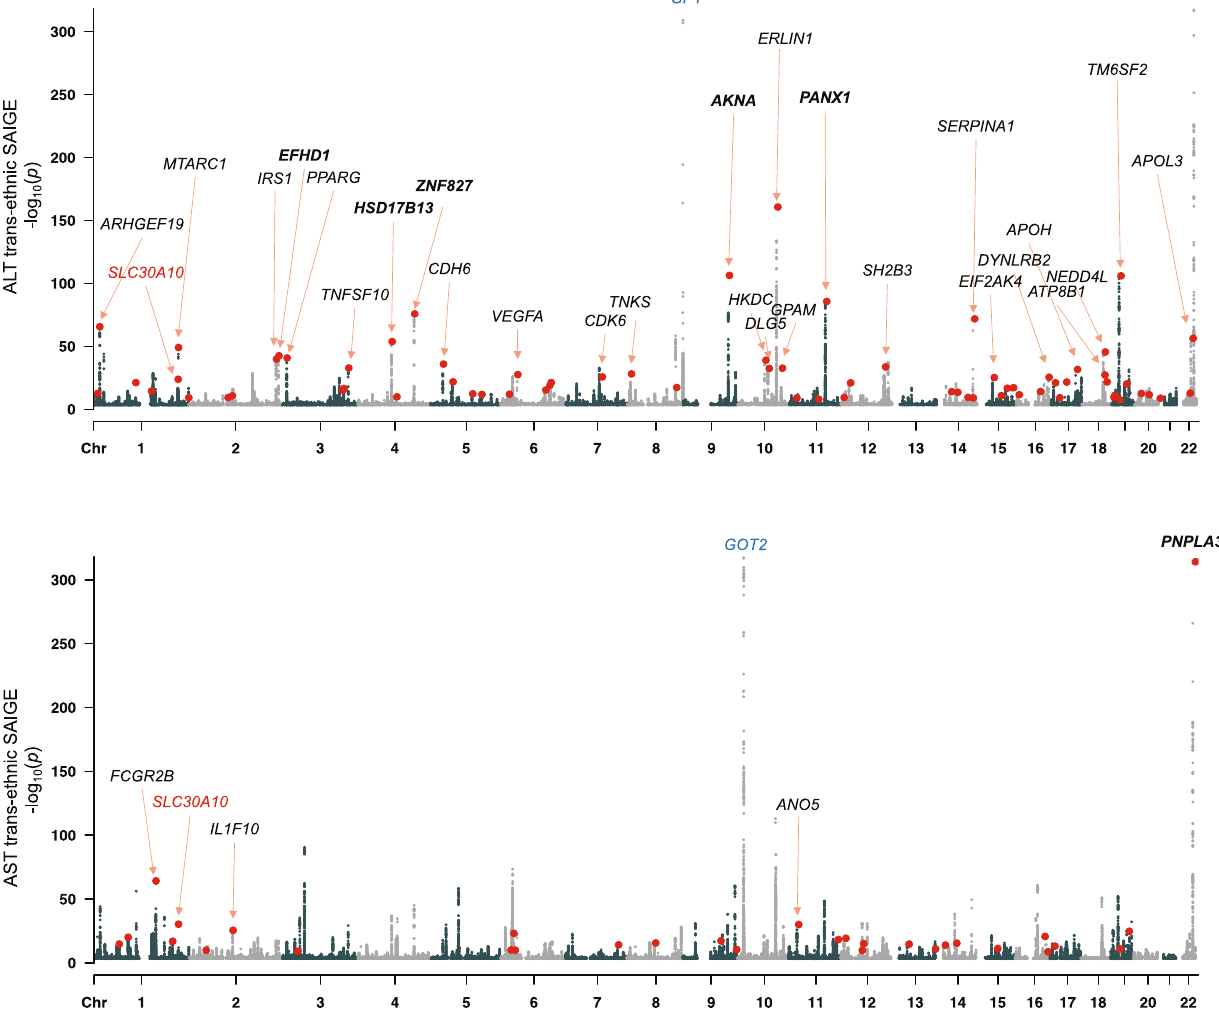
Fig. 1 Manhattan plots showing trans-ancestry GWAS results for ALT and AST. Red dots indicate lead variants for shared signals between the two GWAS; for clarity, the shared signals are marked only once, on the plot for the GWAS in which the more signi fi cant association is detected. Cis-pQTLs (at GPT and GOT2 ) are labeled in blue. Loci with shared signals are labeled (for clarity, only when p < 10 − 25 and only on the GWAS for which the association is most signi fi cant). Loci previously reported to associate with both ALT and AST are named in bold. SLC30A10 , the main topic of this report, is labeled in red on both plots. Source data for this fi gure are available from NHGRI-EBI GWAS catalog accession GCST90013663 and